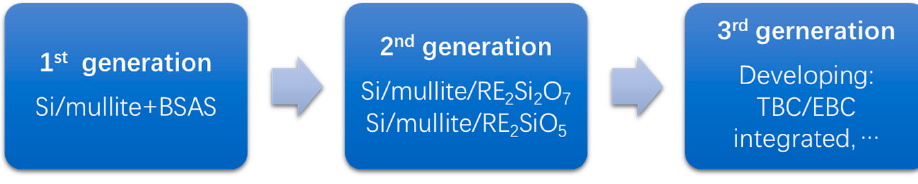
Figure 3. Evolution of EBCs.